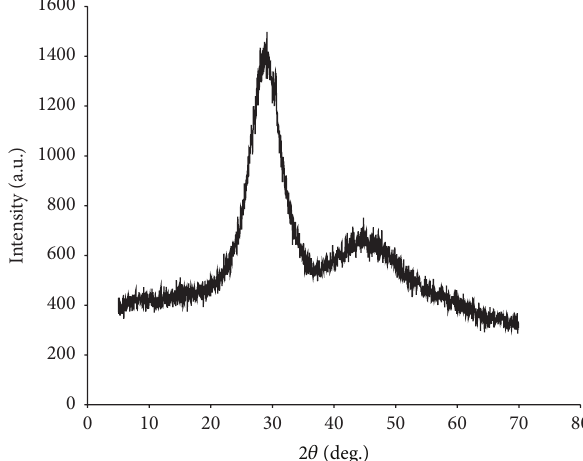
Figure 2: X-ray diffraction of one batch of Na0SR (#7) as an